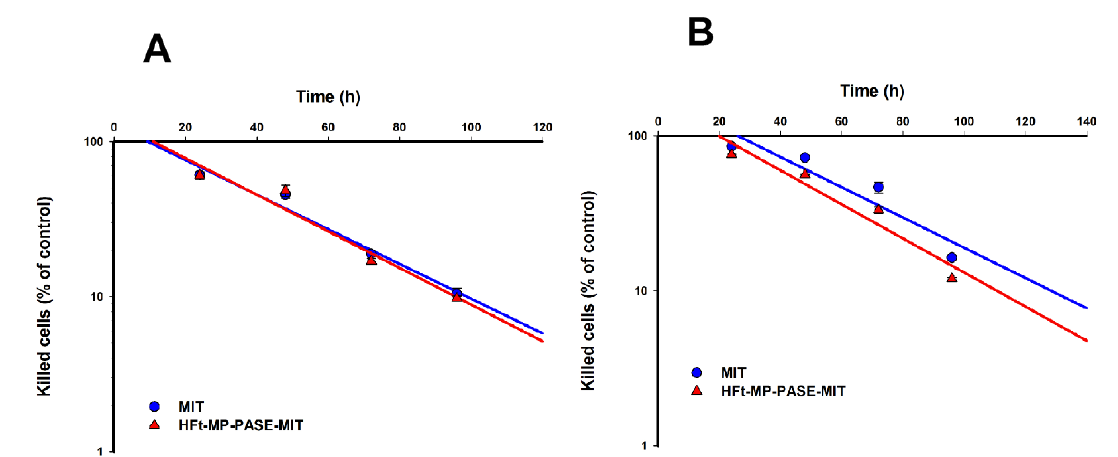
Figure 2. Kinetic curves of cell killing by HFt-MP-PASE-MIT and MIT. PaCa44 pancreatic tumor cells were treated for different time points with an equivalent MIT dose of 1 µM ( A ) or 0.1 uM ( B ) and viability was assessed by XTT assay. Linear regression was applied to fit the experimental data (( A ), r 2 = 0.97 and r 2 = 0.95 for MIT and HFt-MP-PASE-MIT, respectively; ( B ) r 2 = 0.88 and r 2 = 0.93 for MIT and HFt-MP-PASE-MIT, respectively). Three independent experiments were performed ± SEM.